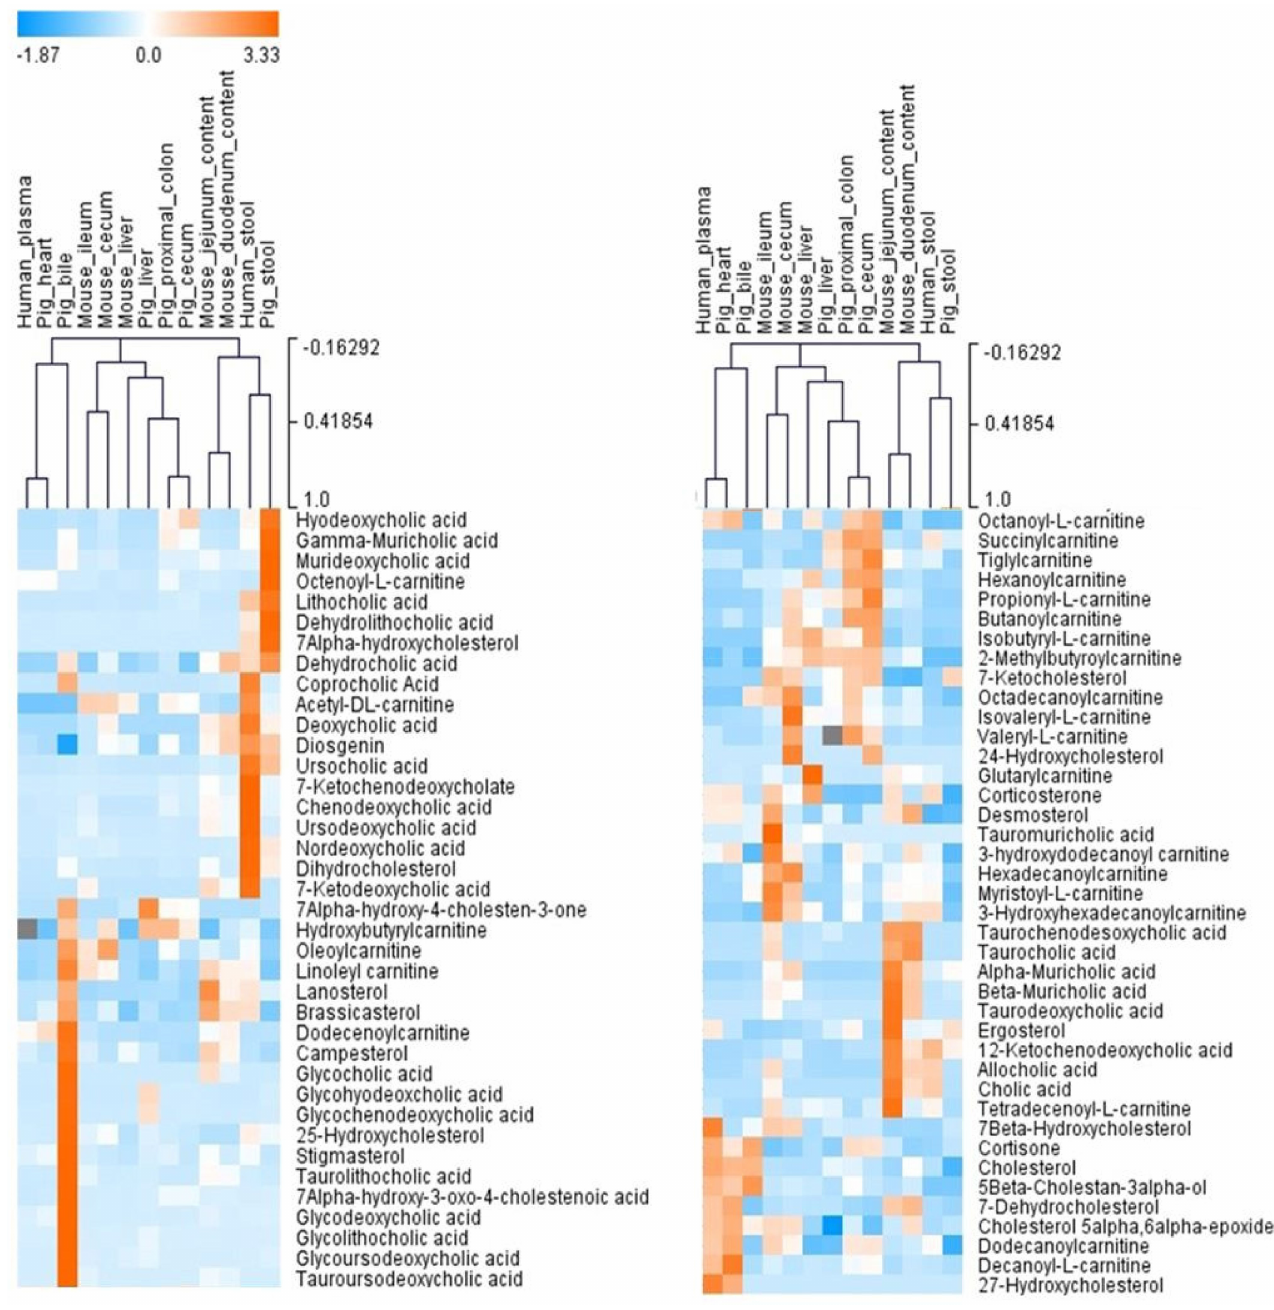
Figure 11. An unsupervised hierarchical clustering analysis based on the qualitative analysis of “BACSMLS”. Each row shows the data for a specific sterol/bile acid/acylcarnitine, and each column shows the “BACSMLS” profiles for the different biological samples. All the identified metabolites were included. Clustering was performed for both metabolites and biological samples (dendrograms not shown for metabolites). The clustering analysis efficiently distinguishes between the different sample types and, more importantly, between the studied species. The raw peak area values from MS-DIAL were used to determine the relative levels of the compounds in the biological samples. For isomers, this value was manually integrated in the vendor software—Agilent MassHunter Qualitative Analysis B.07.00. The peak areas were normalized across all compounds and samples using the mean and the standard deviation